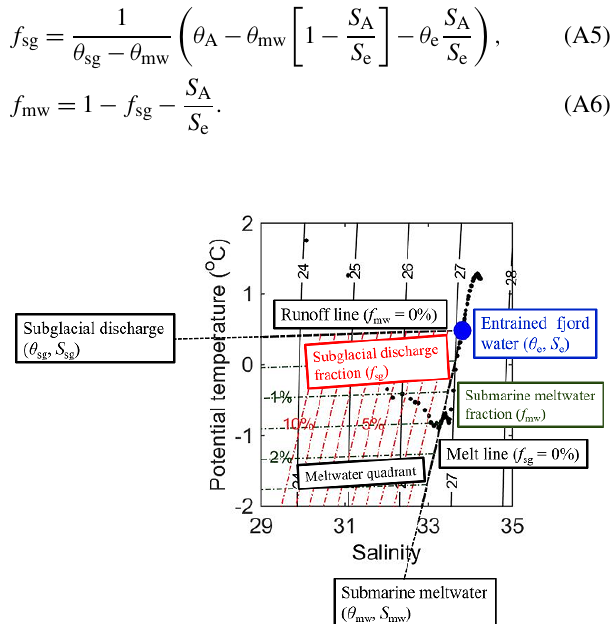
Figure A1. Freshwater fraction analysis in the potential- temperature–salinity diagram. The black dots represent the data ob- served at depths ≥ 5m of station